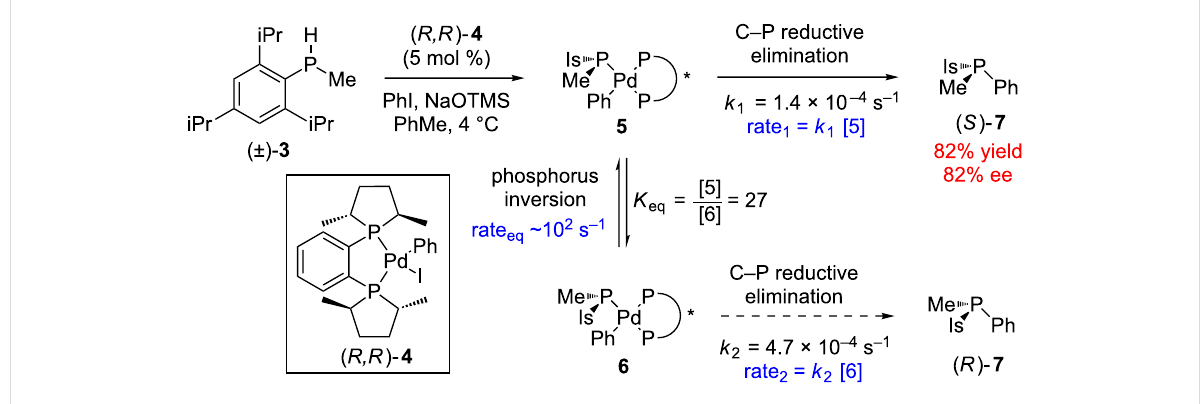
Figure 3: Stereoablative enantioconvergent catalysis.